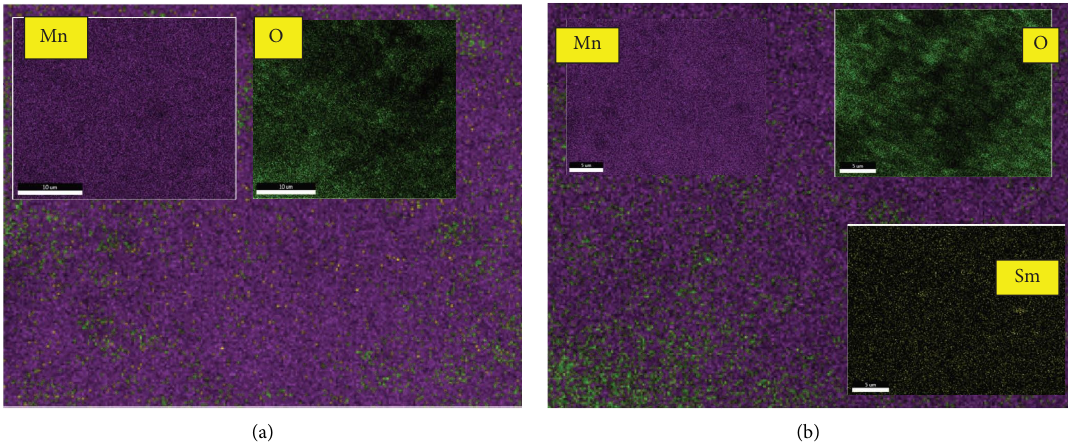
Figure 5: Elemental analysis of (a) Li 4 Mn 5 O 12 and (b) Li 4 Mn 4.75 Sm 0.25 O 12 by EDS